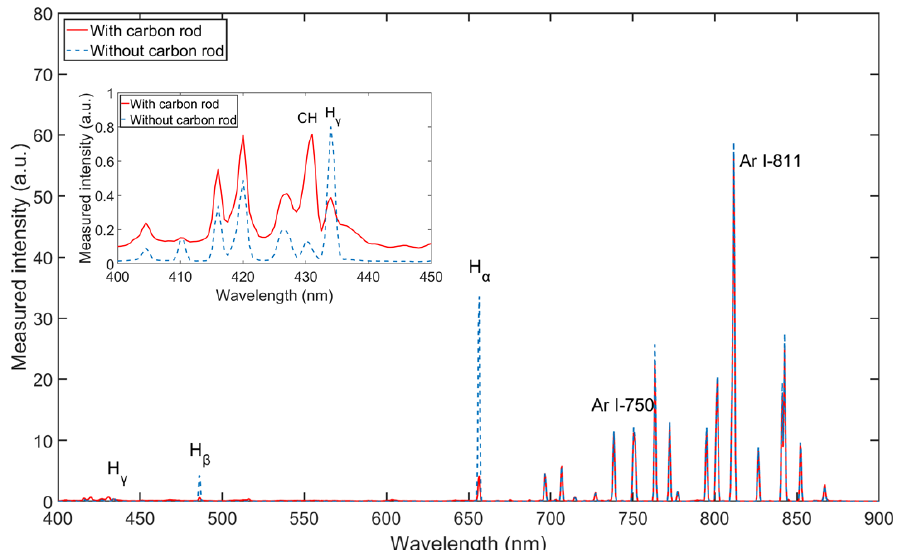
Figure 9. Spectral comparison with and without carbon rod (with 35% H 2 , at pressure of 5 Pa and power of 165 W).